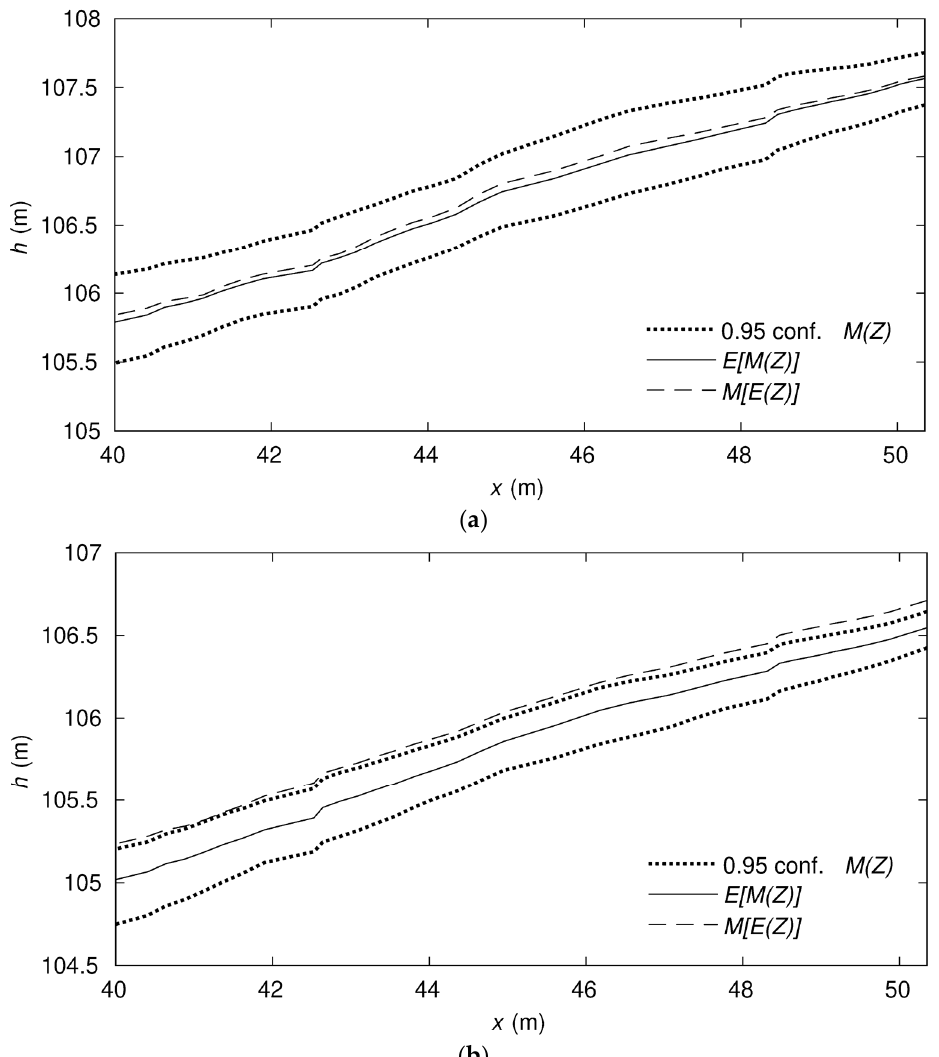
Figure 4. Water levels along the river reach for the correlated elevation uncertainty ( a ) high flows ( b ) bankfull flows.